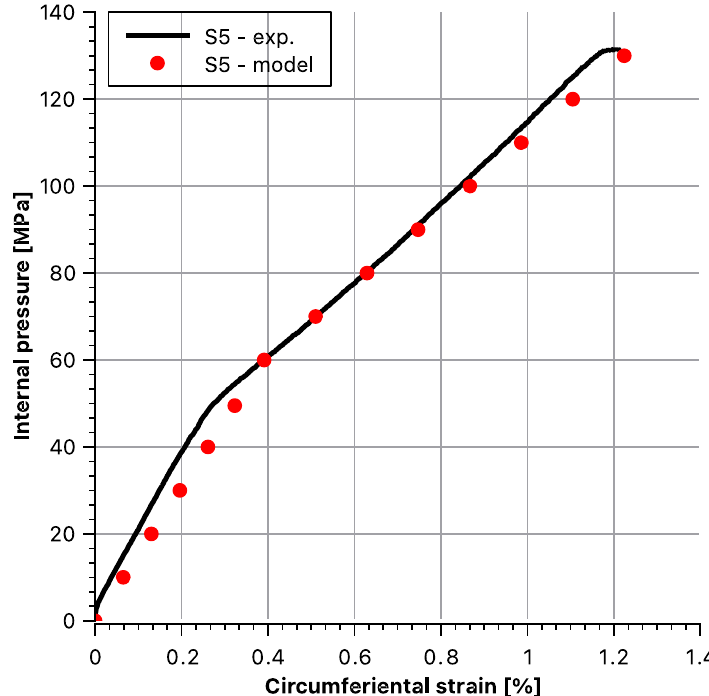
Figure 23. Stress and strain results as a function of internal pressure for sample S4.